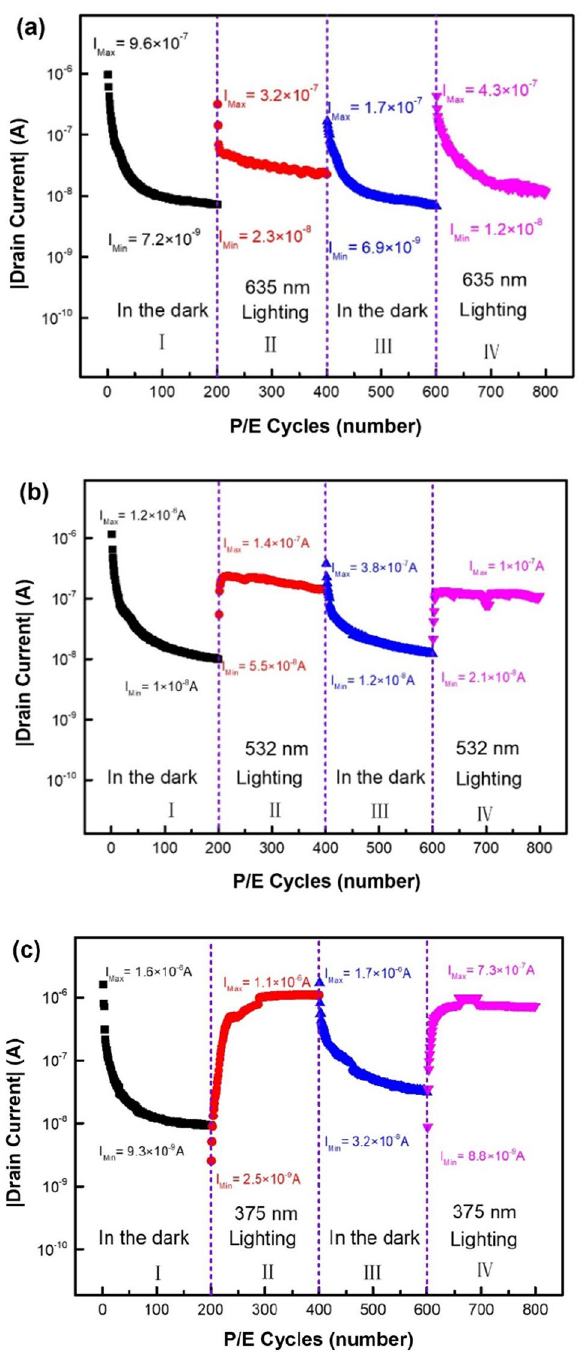
Figure 5. The erasing endurance characteristics of pentacene OFETs with PVN charge-trapping layer under monochromatic lights of ( a ) 635 nm, ( b ) 532 nm and ( c ) 375 nm (V Erasing = 30 V/1 s, V Read = 0 V and V DS = -3